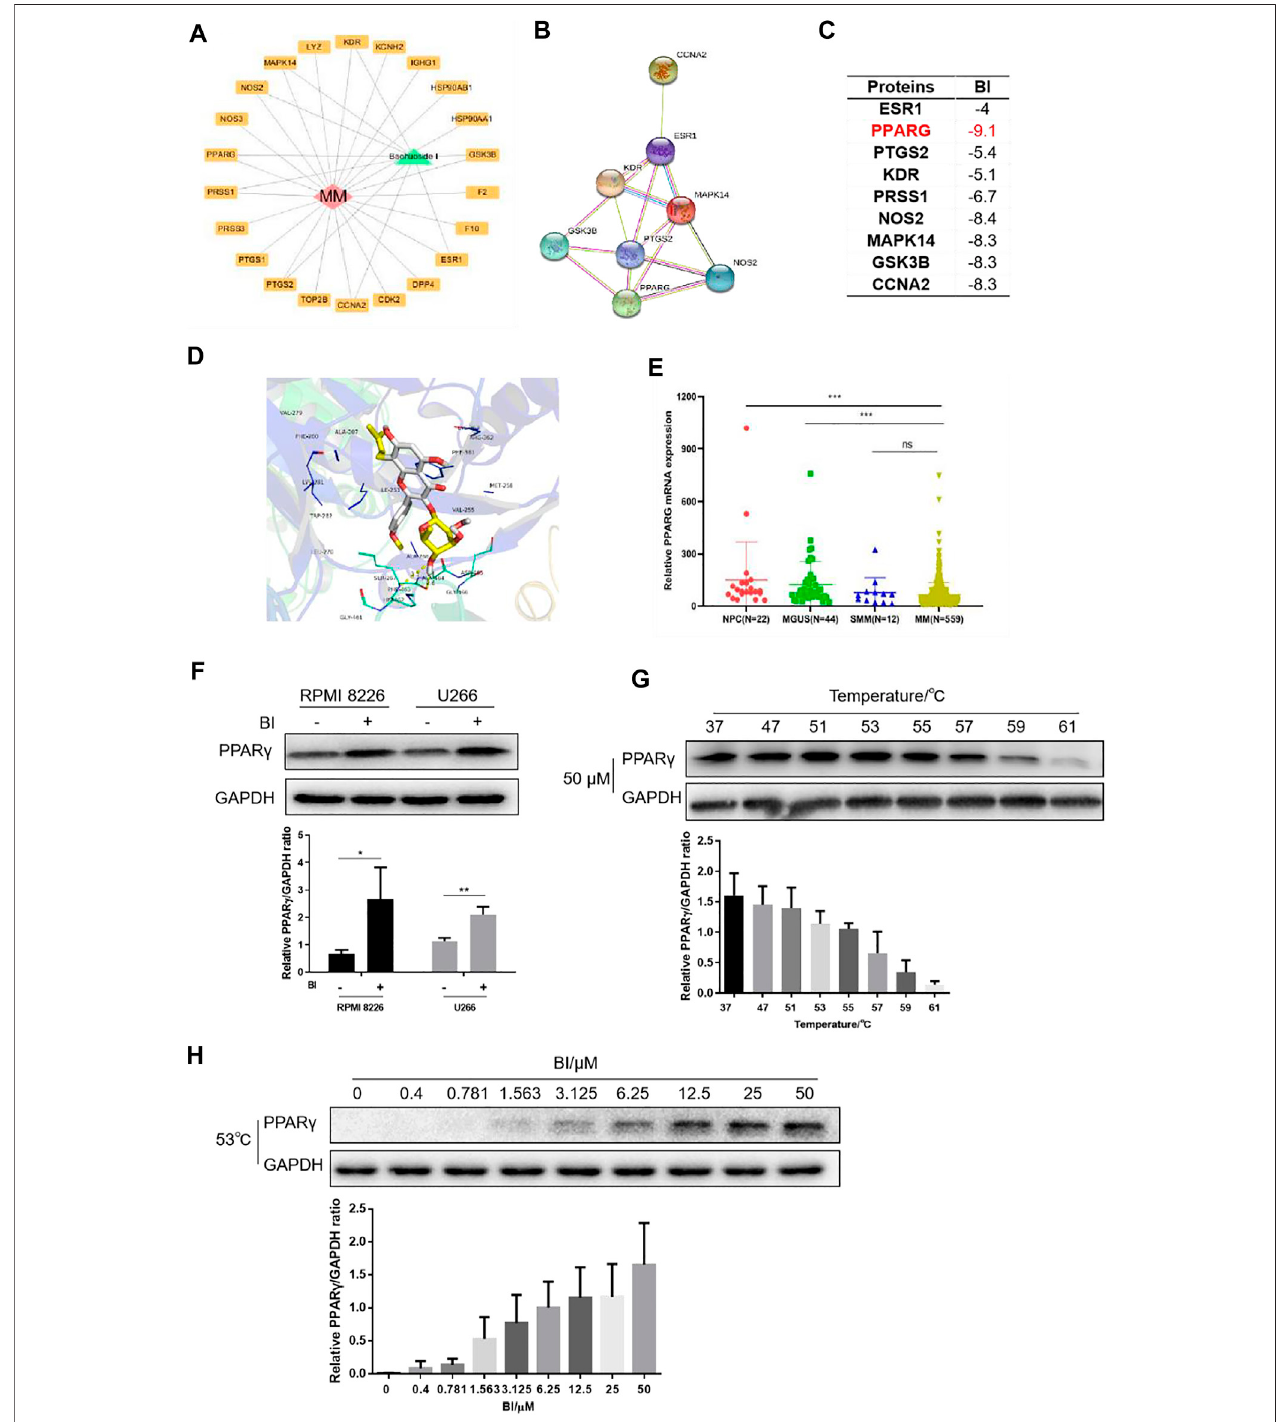
FIGURE3| BIdisplaysabindingabilitytoPPAR γ . (A) CytoscapewasusedtodrawBI ’ s “ drug – target – disease ” networkdiagramwithMM. (B) Interactionbetween protein and protein is obtained through STRING (https://www.string-db.org/). (C) Af fi nity between BI and targets was detected through the PDB database and AutoDockGrid. (D) MoleculardockingmodelofBIandthedrugdiseasetargetwassimulatedbyAutoDockVina. (E) ExpressionofPPAR γ mRNAinnormalpeopleandin MGUS, SMM, and MM patients was examined by the GEO database (GSE5900 and GSE2658). (F – H) Protein expression of PPAR γ was determined by WB after MM cells were exposed to BI (F) ; after MM cells were heated by incremental temperature at 50 μ M BI-treatment (G) ; and after MM cells were exposed with increased concentration of BI at 53 ° C (H) .